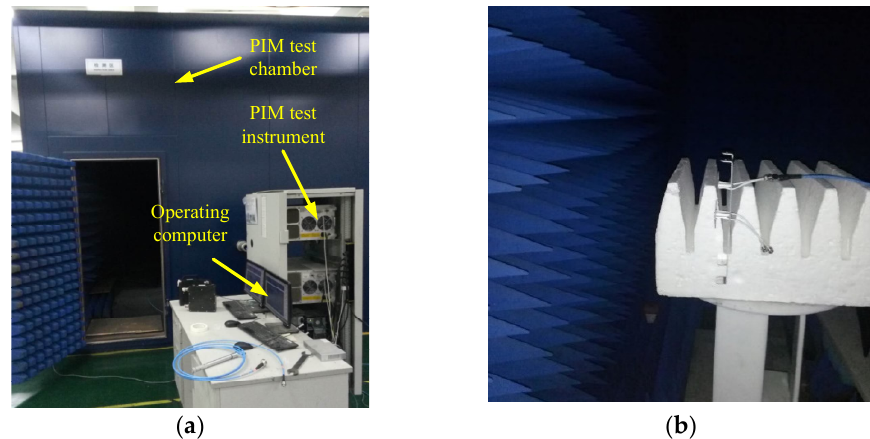
Figure 6. A photograph of chamber A. ( a ) Appearance of the PIM measurement chamber A, ( b ) measurement arrangement in PIM measurement chamber A.